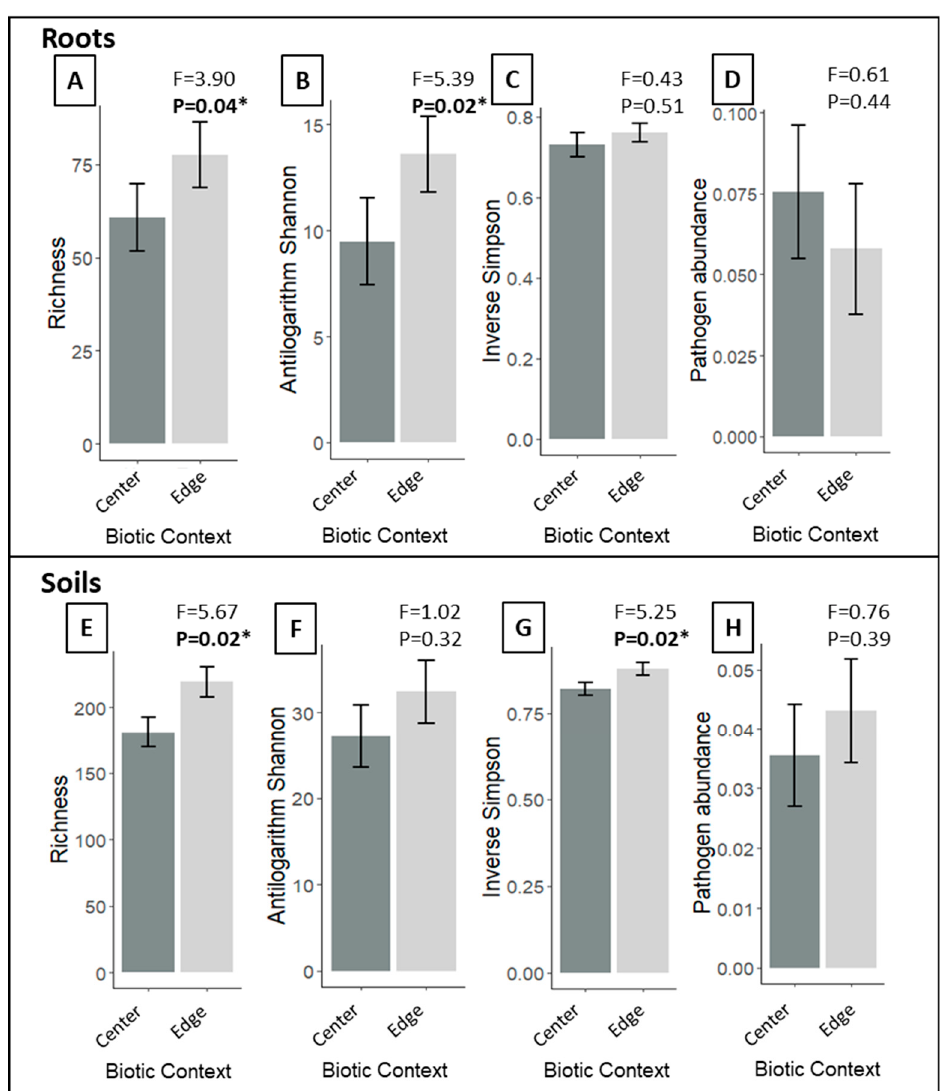
Figure 4. Fungal richness, antilogarithm of Shannon’s entropy index, inverse of Simpson’s concentration index, and total putative plant pathogen abundance in center (dark grey) and edge (light grey) biotic contexts within native communities. ( A – D ) display estimated marginal means and standard errors of root fungal endosphere responses to biotic context. ( E – H ) show estimated marginal means and standard errors of soil fungal community responses to biotic context. P -values less than 0.1 are highlighted in bold and labeled with the following notation: † p < 0.1, * p < 0.05, ** p < 0.01, *** p < 0.001.